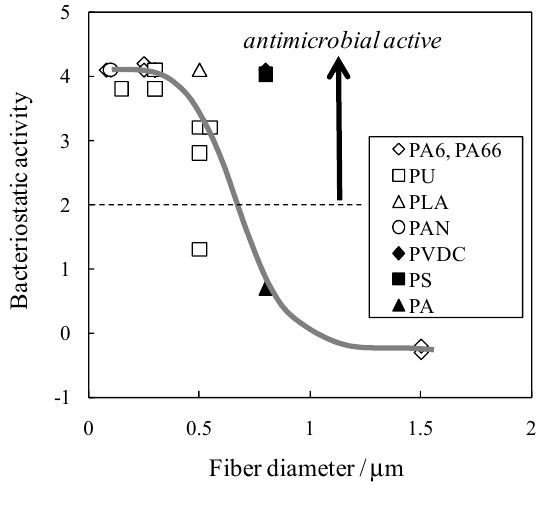
Figure 12. Relationship between fiber diameter and bacteriostatic activity (Adapted from